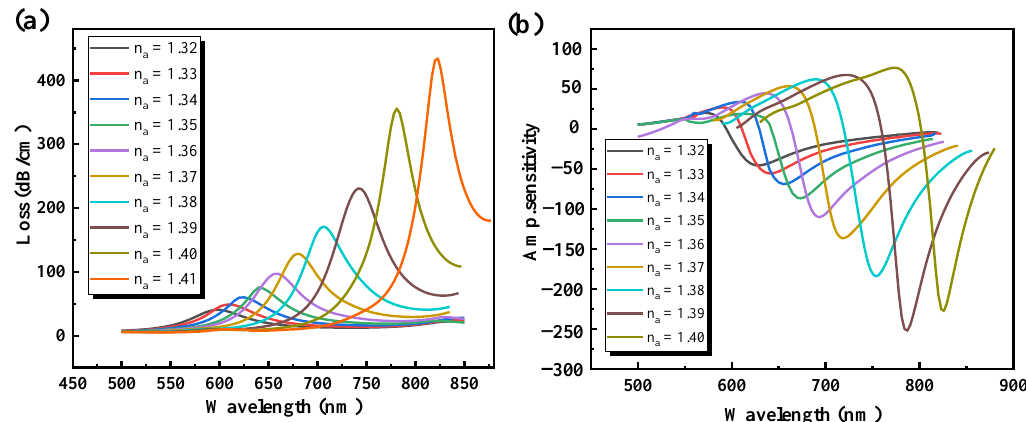
Figure 7. ( a ) Loss spectra curves at different n a with Λ = 1.8 μ m, d = 0.4 Λ , d1 = 0.2, t g = 40 nm, and L G = 3; ( b ) amplitude sensitivity.